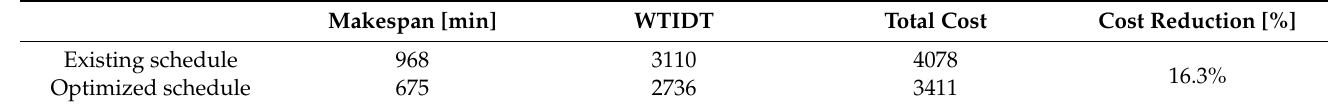
Figure 12. Comparison of machines’ idle time in the actual and optimized schedule. Table 4. Cost calculation for the existing and optimized schedules.